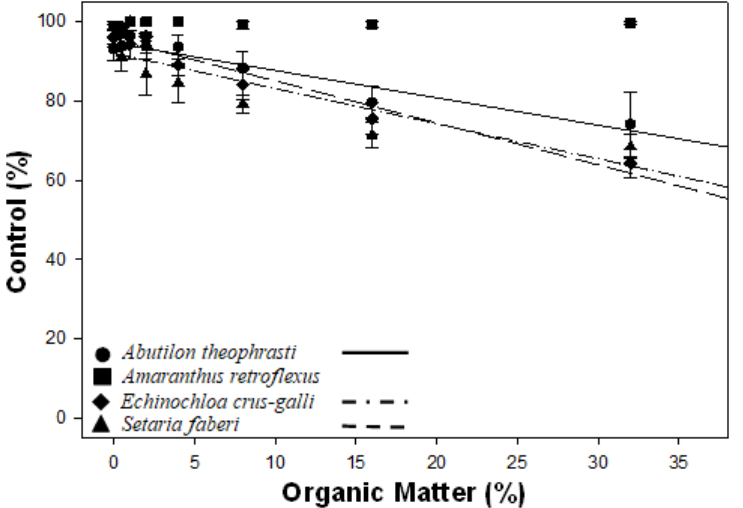
Figure 2. Control of flumioxazin on select weed species as affected by soil organic matter content. Fitted lines are calculated by the linear regression equation ( y = a + bx ) for Abutilon theophrasti , Echinochloa crus-galli , and Setaria faberi ( p < 0.05). Flumioxazin control on A. theophrasti, E. crus-galli , and S. faberi decreased with increasing soil organic matter content. Flumioxazin control on Amaranth retroflexus did not change across soil organic matter content ( p > 0.05). The vertical bars represent the standard error of means.